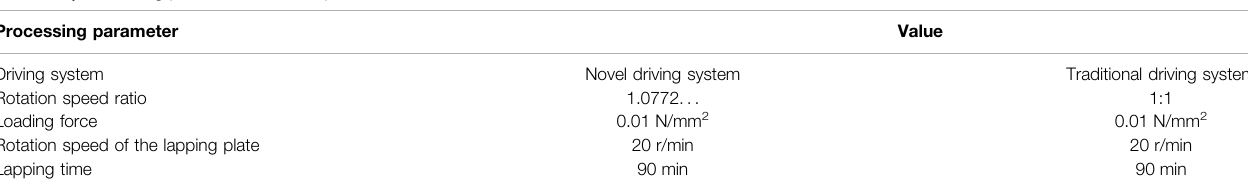
TABLE 2 | Processing parameters in the experiment. Processing